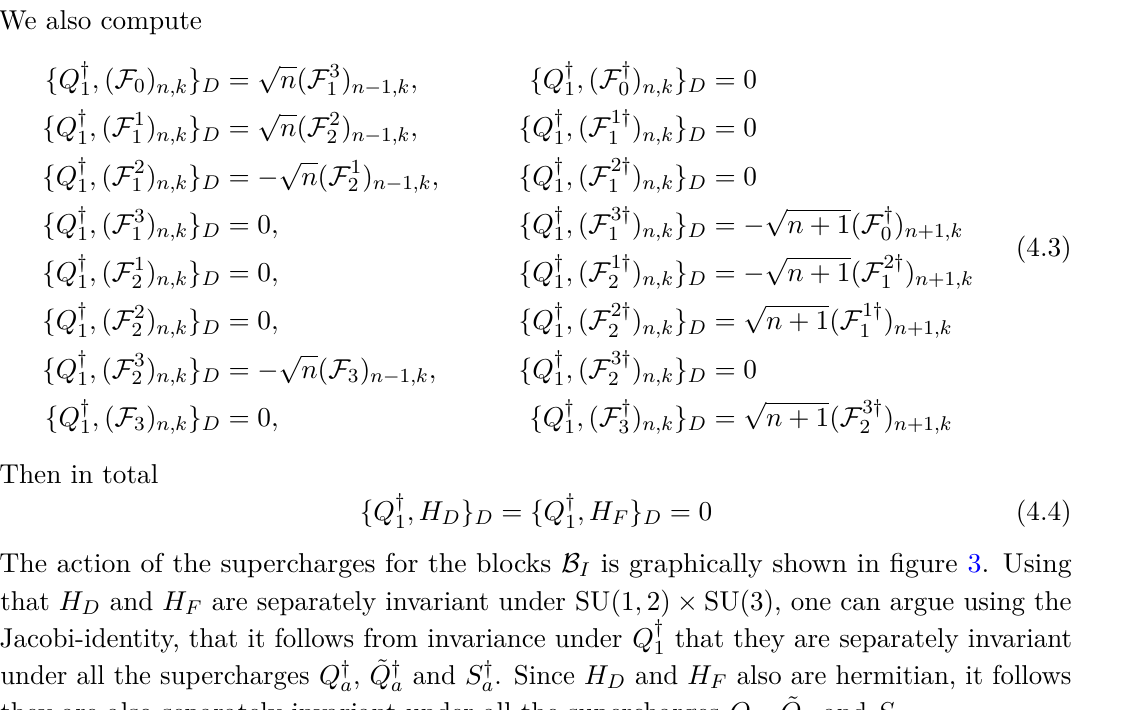
. The actions on the F blocks follow 2